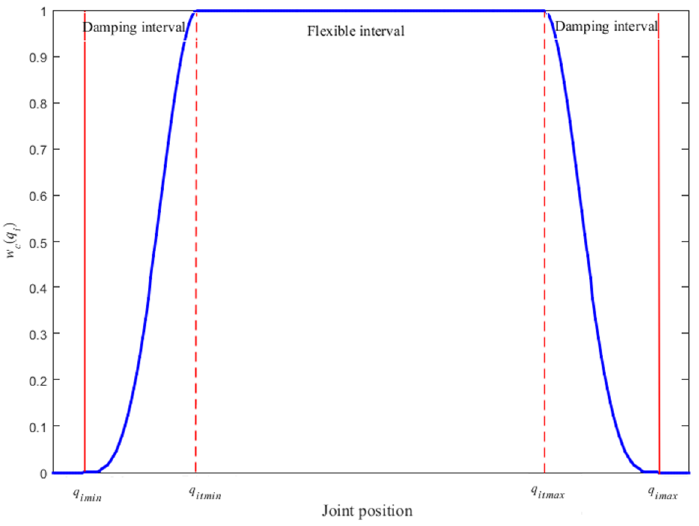
w q for i -th joint position in clamping WLN Figure 2. The change of ( ) c i